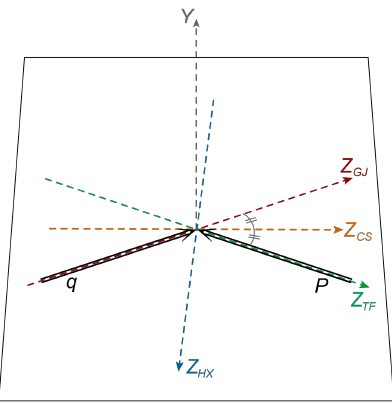
Figure 1 . Reference frames for the process γ ∗ ( q ) + p ( P ) → J/ψ ( P ψ ) + X in which the J/ψ is at rest: Helicity (HX), Target (TF), Collins-Soper (CS) and Gottfried-Jackson (GJ). They are related to each other by a rotation around the Y -axis. See appendix A for further